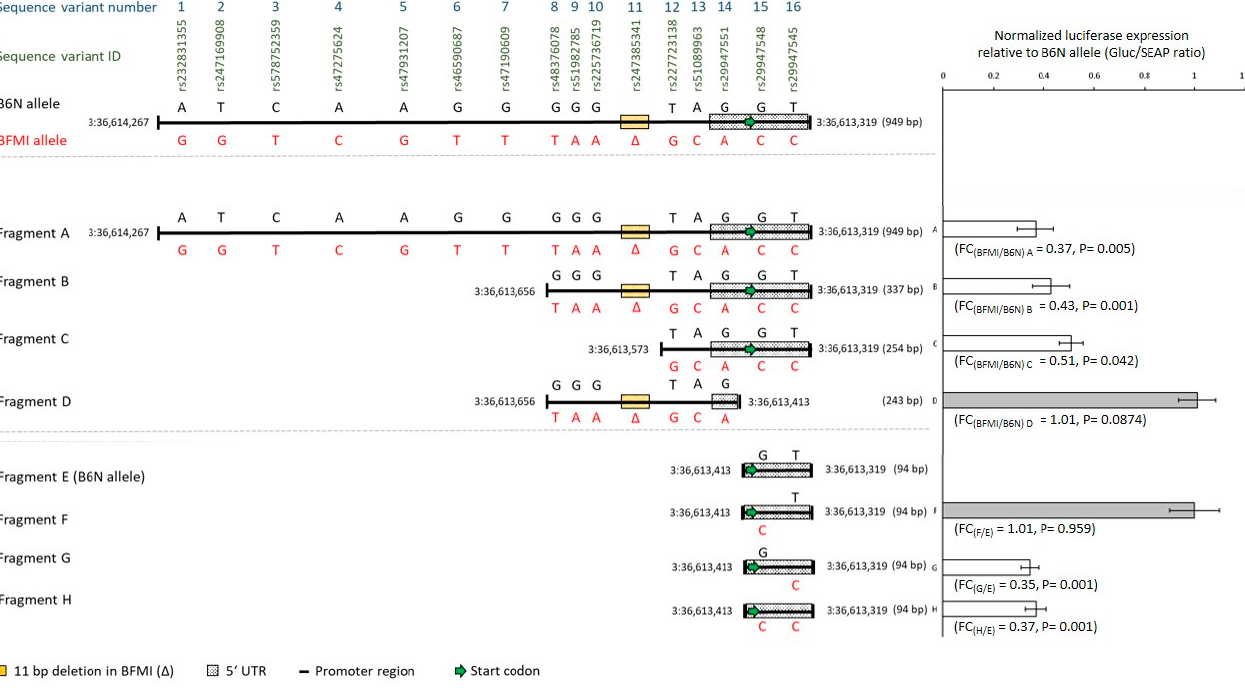
Figure 1. On the left side, promoter fragments are shown that were tested for their effect on the expression of luciferase as the reporter gene in the dual-luciferase plasmid (ZX-103). The full-length fragment A comprises the whole Bardet–Biedl Syndrome 7 ( Bbs7 ) promoter region of 949 bp between 3:36,613,319 and 3:36,614,267. The 5 ′ UTR is shown with a patterned black and white box. Fragments B, C, and D are shorter cloned promoter fragments. Fragments E through H (3:36,613,319 to 3:36,613,413) were synthesized. E comprises the shortened C57BL/6NCrl (B6N) haplotype; F, G, and H contain Berlin Fat Mouse Inbred (BFMI) alleles in different combinations. On top, all 16 sequence variants across the promoter fragment are shown with their ID and numbers from 1 to 16. Above every fragment, the B6N alleles are depicted (black), below the BFMI alleles (red). On the right side, a bar chart shows the normalized luciferase expression (GLuc/SEAP ratios) of the tested BFMI promoter variants versus B6N as the reference. Significantly reduced expression was evident for BFMI fragments A, B, and C (FC (BFMI/B6N)A = 0.37, FC (BFMI/B6N)B = 0.43, FC (BFMI/B6N)C = 0.51), but not for nucleotide polymorphism (SNP) 16 (rs29947545). The BFMI allele of SNP rs29947545 is required (fragments G and H) for significantly reduced expression (FC (G/E) = 0.35, FC (H/E) = 0.37, FC (F/E) = 1.01). Normalized luciferase expression (GLuc/SEAP ratio) was plotted as mean ± standard deviation of